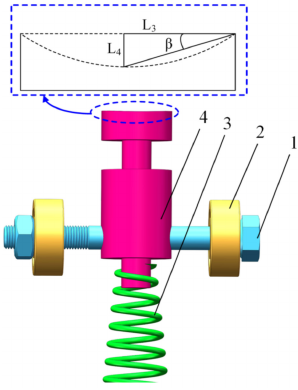
Figure 3. The structural diagram of the forced seed feeding device. 1. Fixing device, 2. rolling bearing, 3. spring, and 4. pushing shaft.